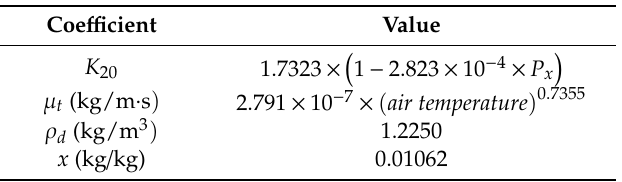
Table 3. Values of coe ffi